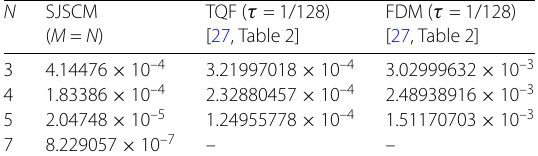
Table 14 L ∞ error norm for u ( x , t ) = v ( x , t ) of Example 2 with 0 ≤ x ≤ 3, α 1 = α 2 = 0.4 and μ = η = 0 N SJSCM ( M = N